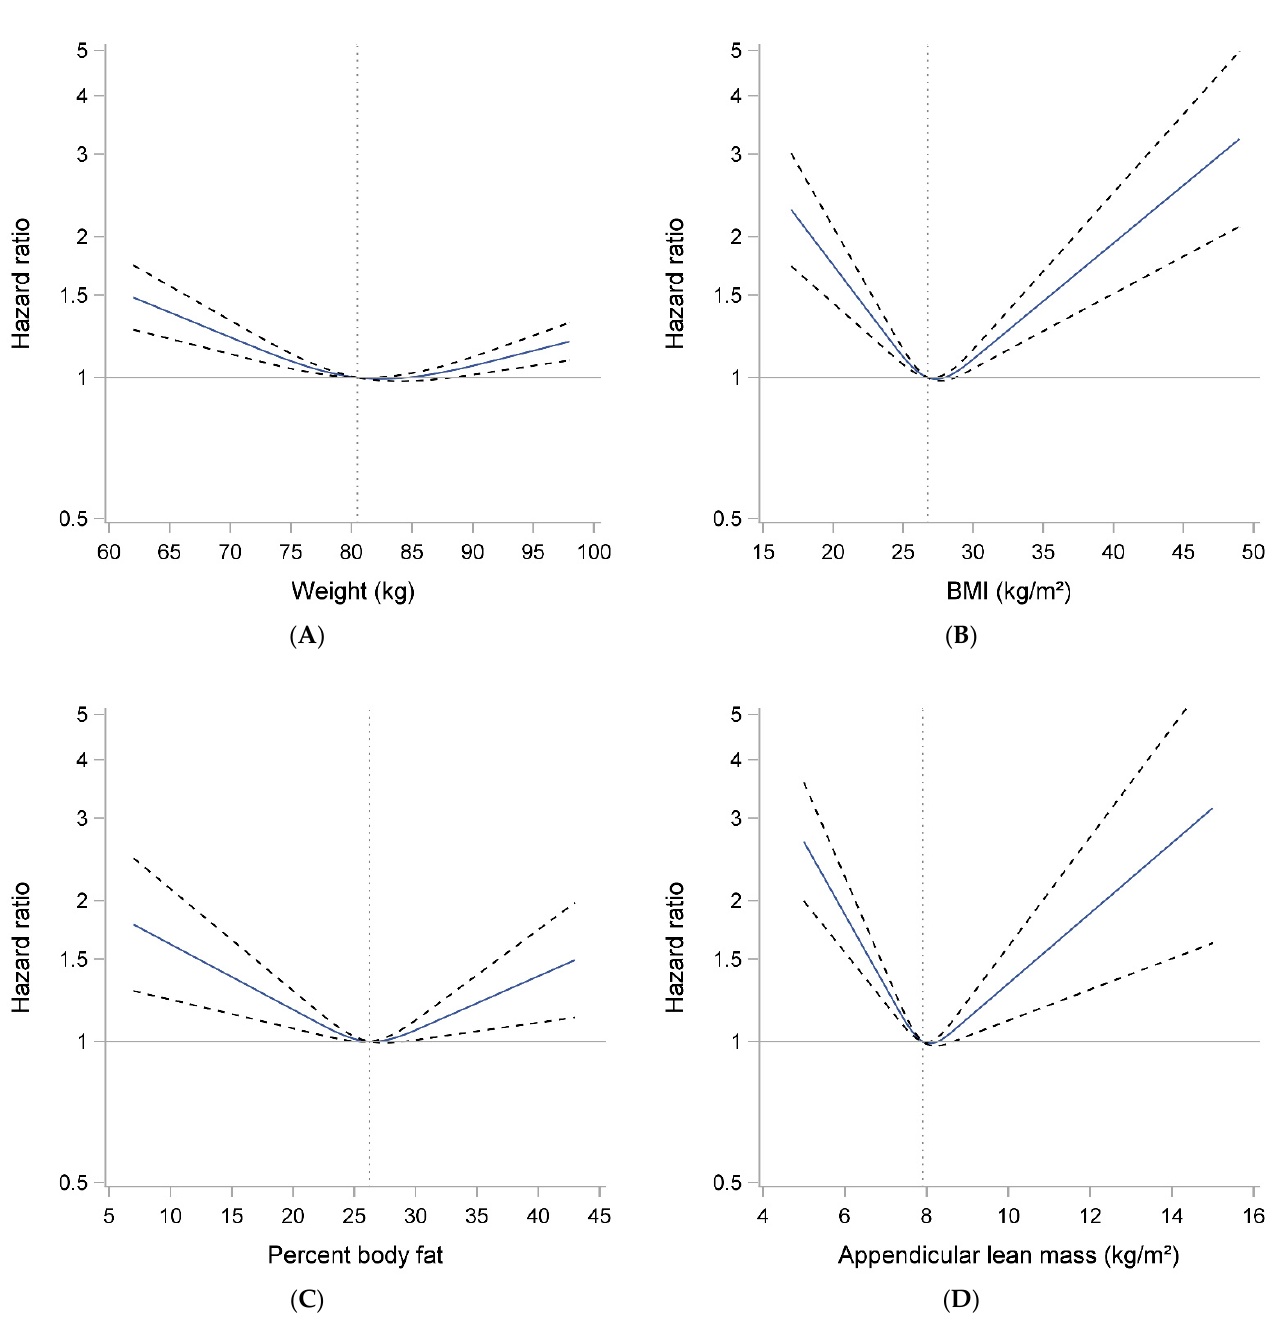
Figure 3. Spline plots of the association between body size and composition (( A ) Weight, ( B ) BMI, ( C ) Percent Body Fat and ( D ) Appendicular lean mass) and mortality in older men. Models are adjusted for age, clinical site, race, total energy intake, smoking and comorbidity. Weight and percent fat models adjusted additionally for height.